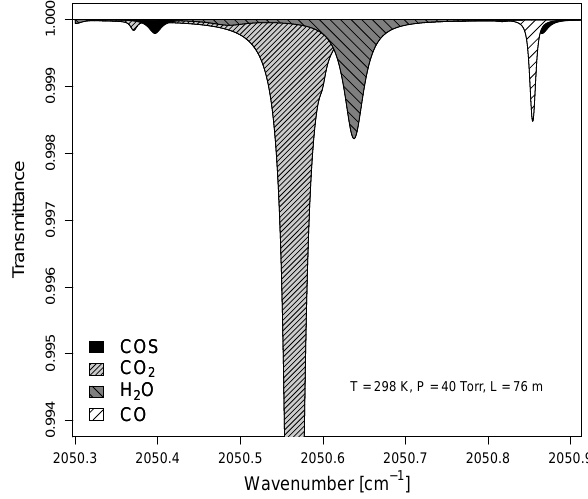
Figure 1. Simulated transmission spectrum of ambient concen- trations of COS (500ppt), CO 2 (500ppm), H 2 O (1.5%) and CO (200ppb) with sample cell conditions: temperature 298K, pressure 53.3hPa (40Torr) and the absorption path length 76m. A small wa- ter band at 2050.5cm − 1 can interfere with COS at 2050.4cm − 1 and can affect the COS correction for water vapor without a split fit at 2050.45cm − 1 (Sect.